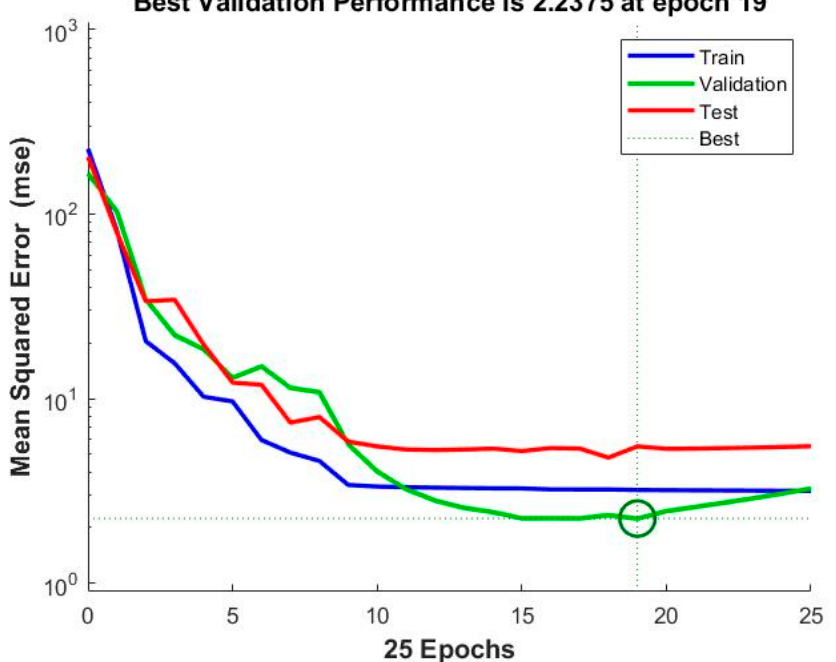
Figure 5. The Mean Square Error in 25 Epochs.